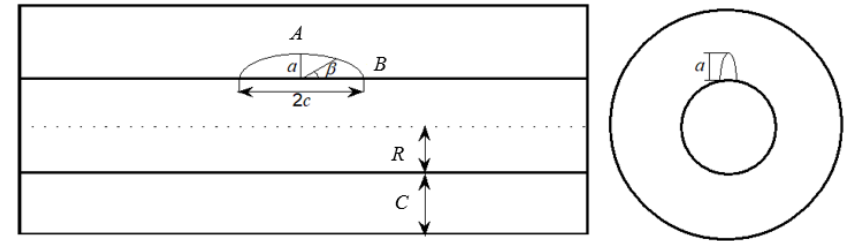
Figure 1. Schematic diagram of semi-elliptic initial defect: c —half length of the semi-elliptical crack; a —radial depth of the initial defect; R —inner steel radius; C —concrete cover depth; β —position angle; A —deepest points of the crack in vertical direction; B —deepest points of the crack in horizontal directions.